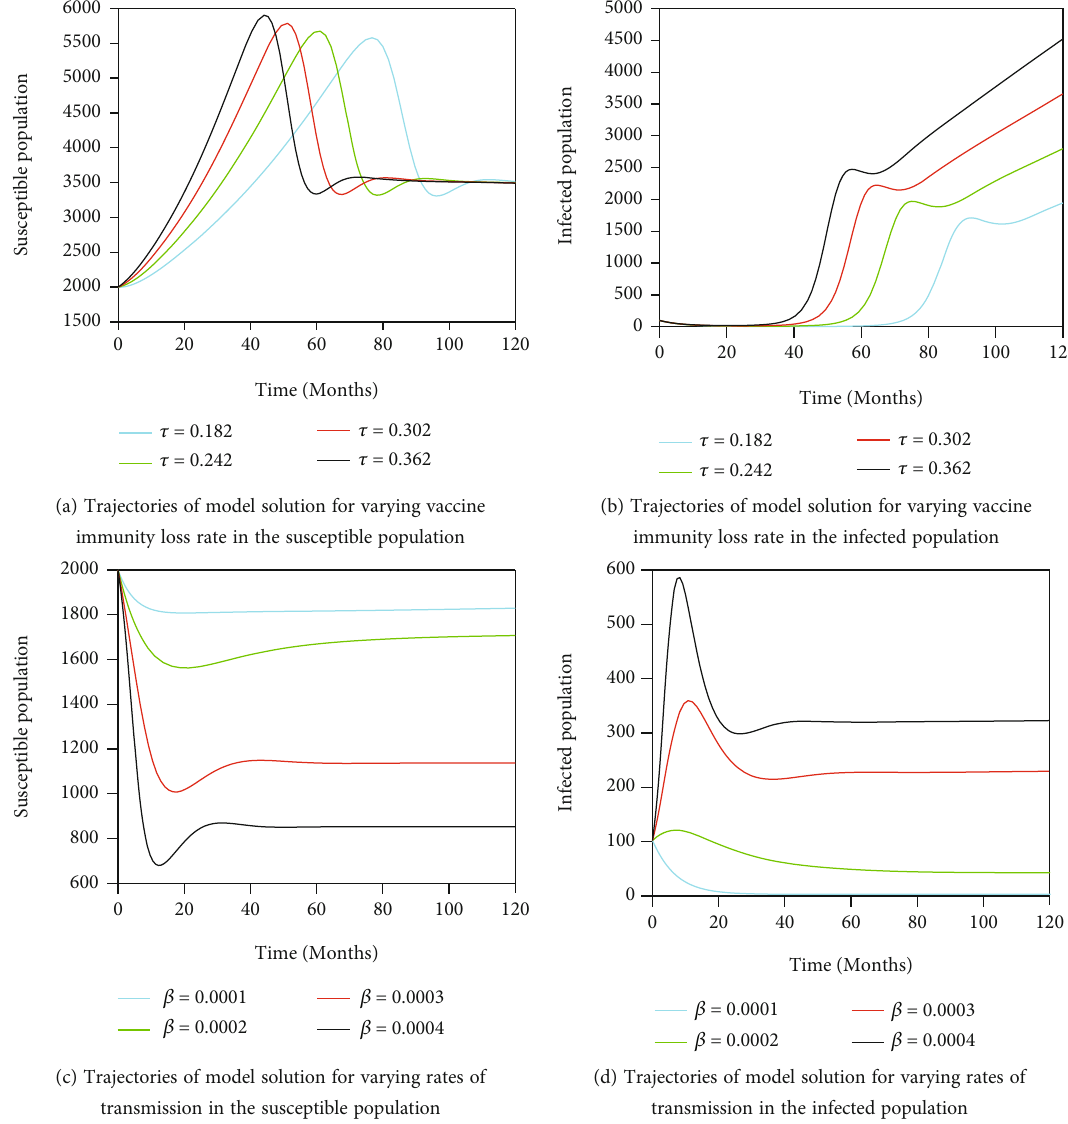
Figure 4: Trajectories of model solution for varying rates of vaccine-induced immunity loss and